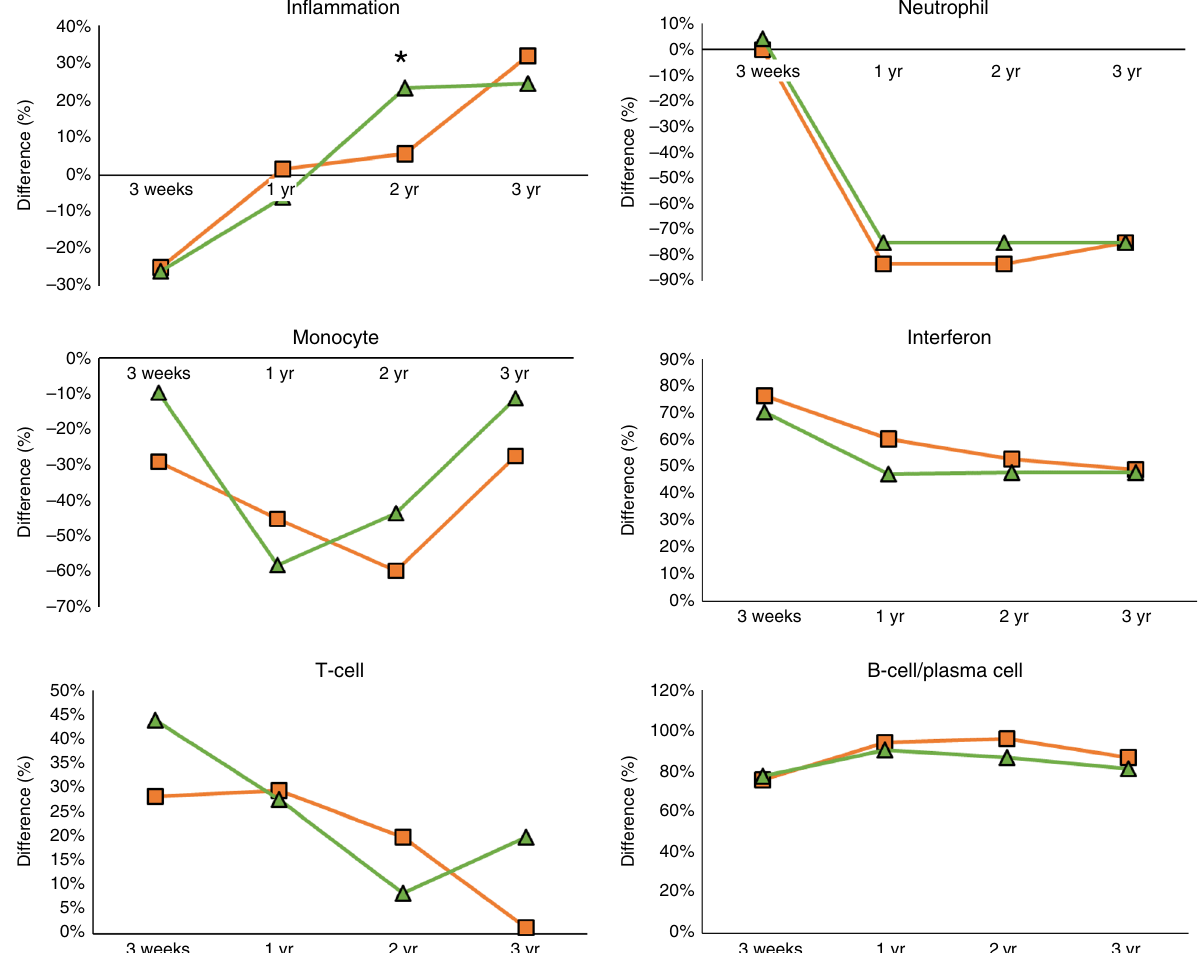
Fig. 6 Longitudinal modular analyses of infants with cCMV infection. Mean percent difference* in modular expression of innate (in fl ammation, neutrophil, monocytes, interferon) and adaptive immunity (T cell and B cell/plasma cell) modules are plotted and compared over time (baseline, 1 year, 2 years, and 3 years of age) for infants with symptomatic (orange square) and asymptomatic (green diamond) congenital CMV infection. *The mean percent difference was calculated by the percentage of genes upregulated (positive percent) minus the percentage of downregulated genes (negative percent) within each module. When the biological functions were represented by more than one module (i.e., interferon, in fl ammation, T cells, see Fig. 3), modular mean was derived and the percentage difference calculated as explained